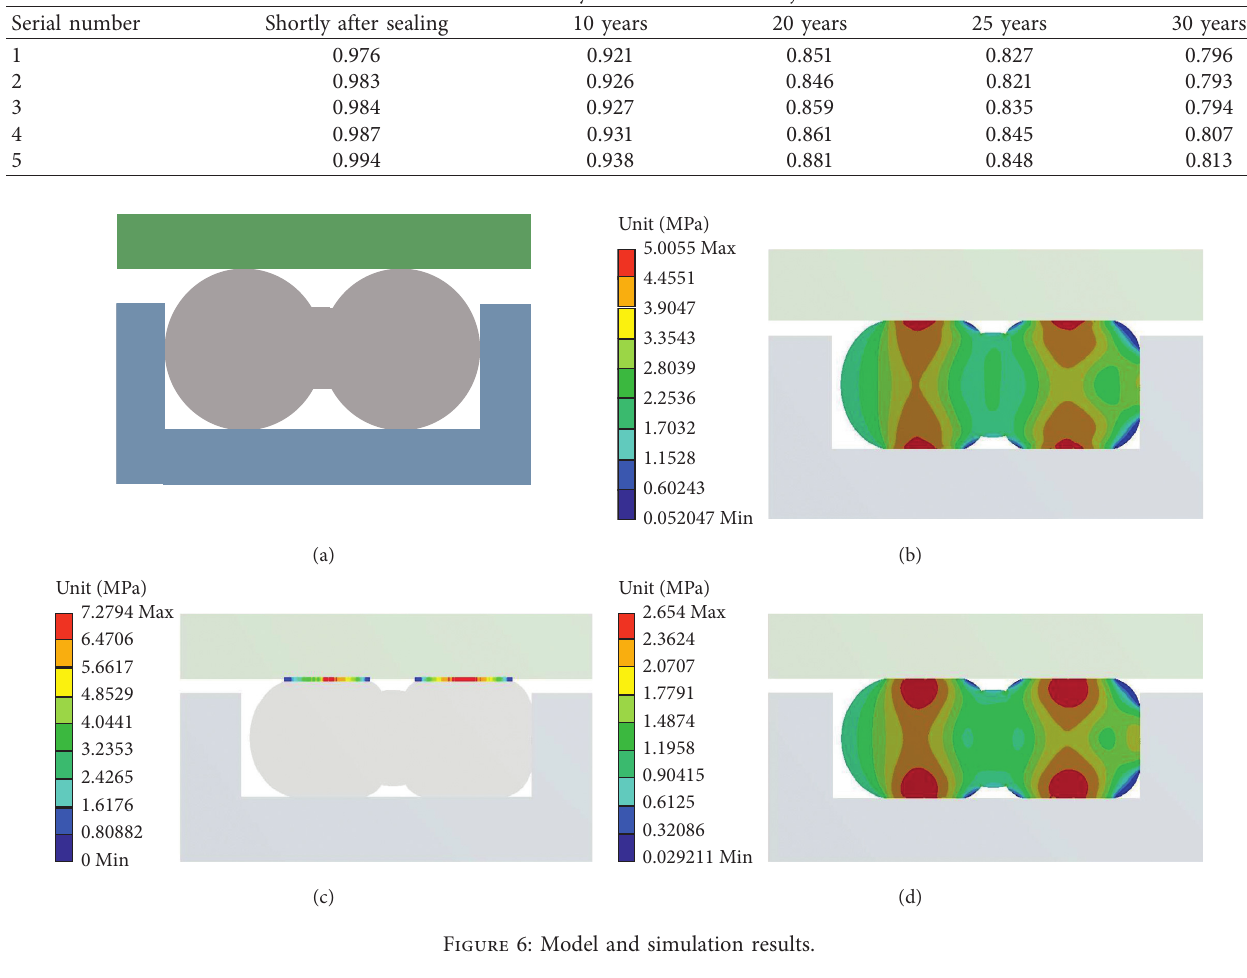
Figure 6: Model and simulation